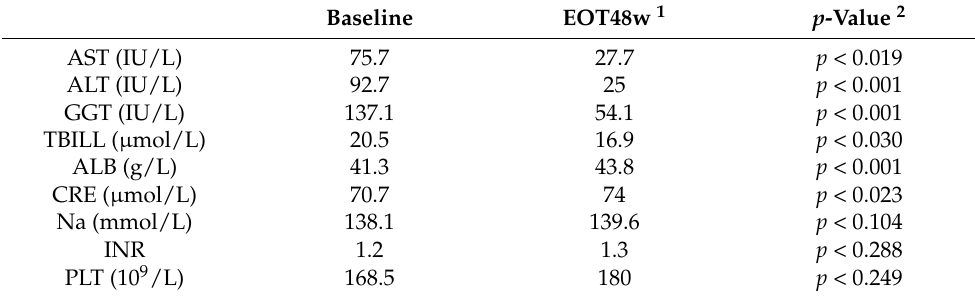
Table 2. Comparison of laboratory tests before and after treatment.